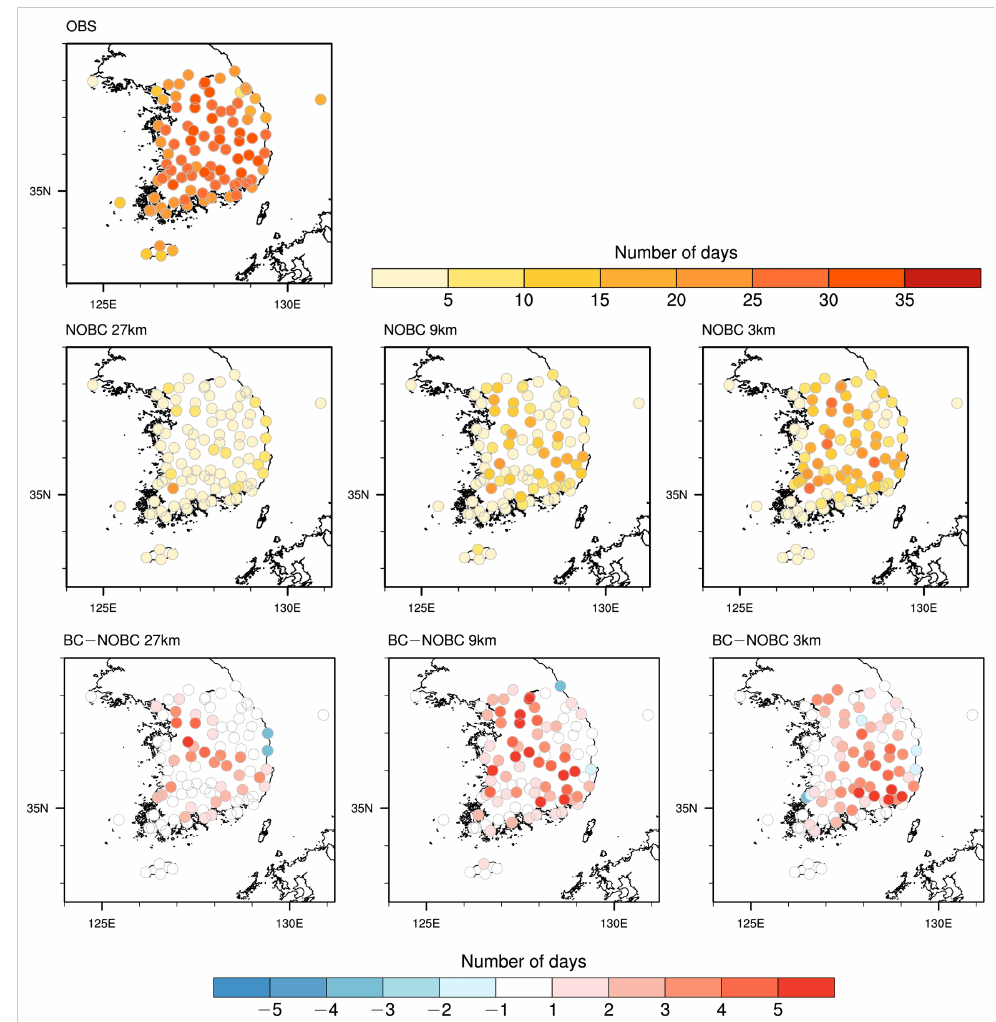
Figure 13. Thenumber of days with Tmax exceeding 30 ◦ C for the 94 stations, derived from obser- vations and WRF simulation in CASE 1. Below, the three figures show the difference in the index between BC and